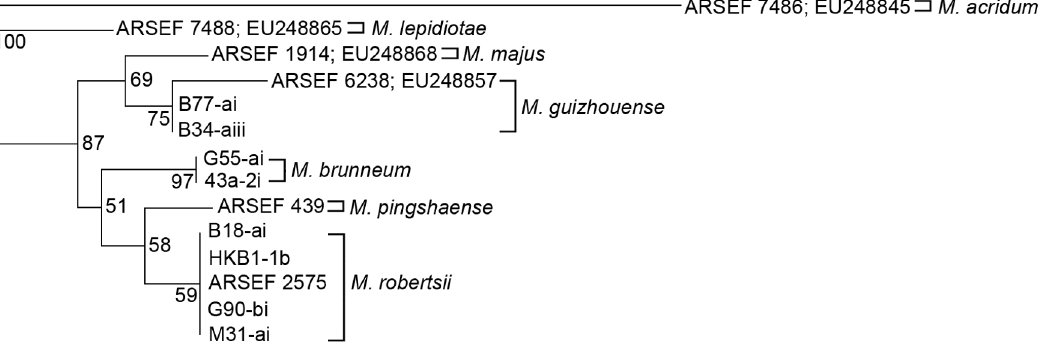
Figure 1. Maximum parsimony (MP) phylogenetic tree of 5 9 EF-1a´ sequences of Metarhizium isolates. Bootstrap values are based on 1000 pseudoreplicates.